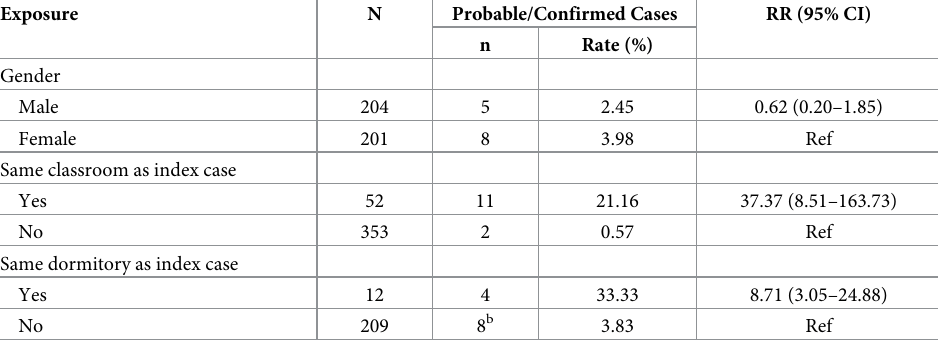
Table 2. Probable/confirmed TB cases among students in the same grade with index SS(+) case, by exposures: Zhejiang Province, China, 2016–2019 a . Exposure N